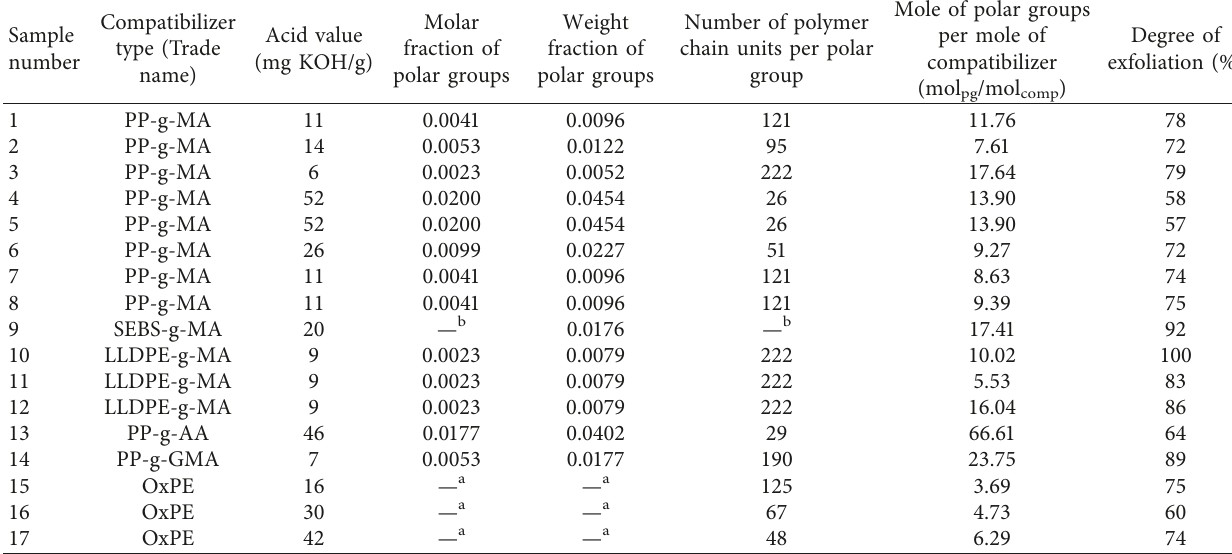
Table 2: Parameters describing the compatibilizer polarity and characterizing the quality of the nanoclay dispersion.